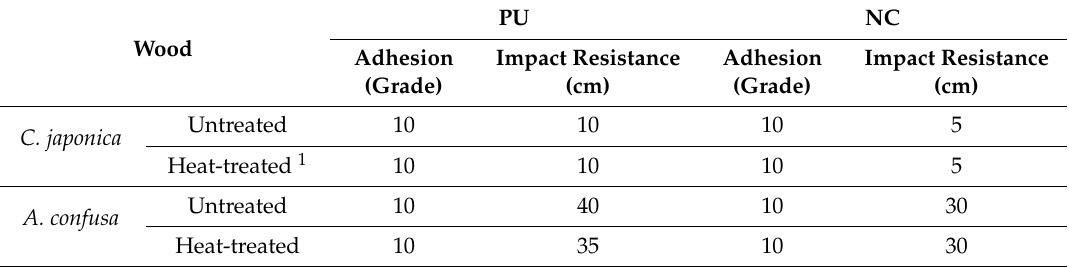
Table 2. Adhesion and impact resistance of untreated and heat-treated Japanese cedar ( Cryptomeria japonica )( a )andFormosaacacia( Acaciaconfusa )woodfinishedwithpolyurethane(PU)andnitrocellulose lacquer (NC) coatings.